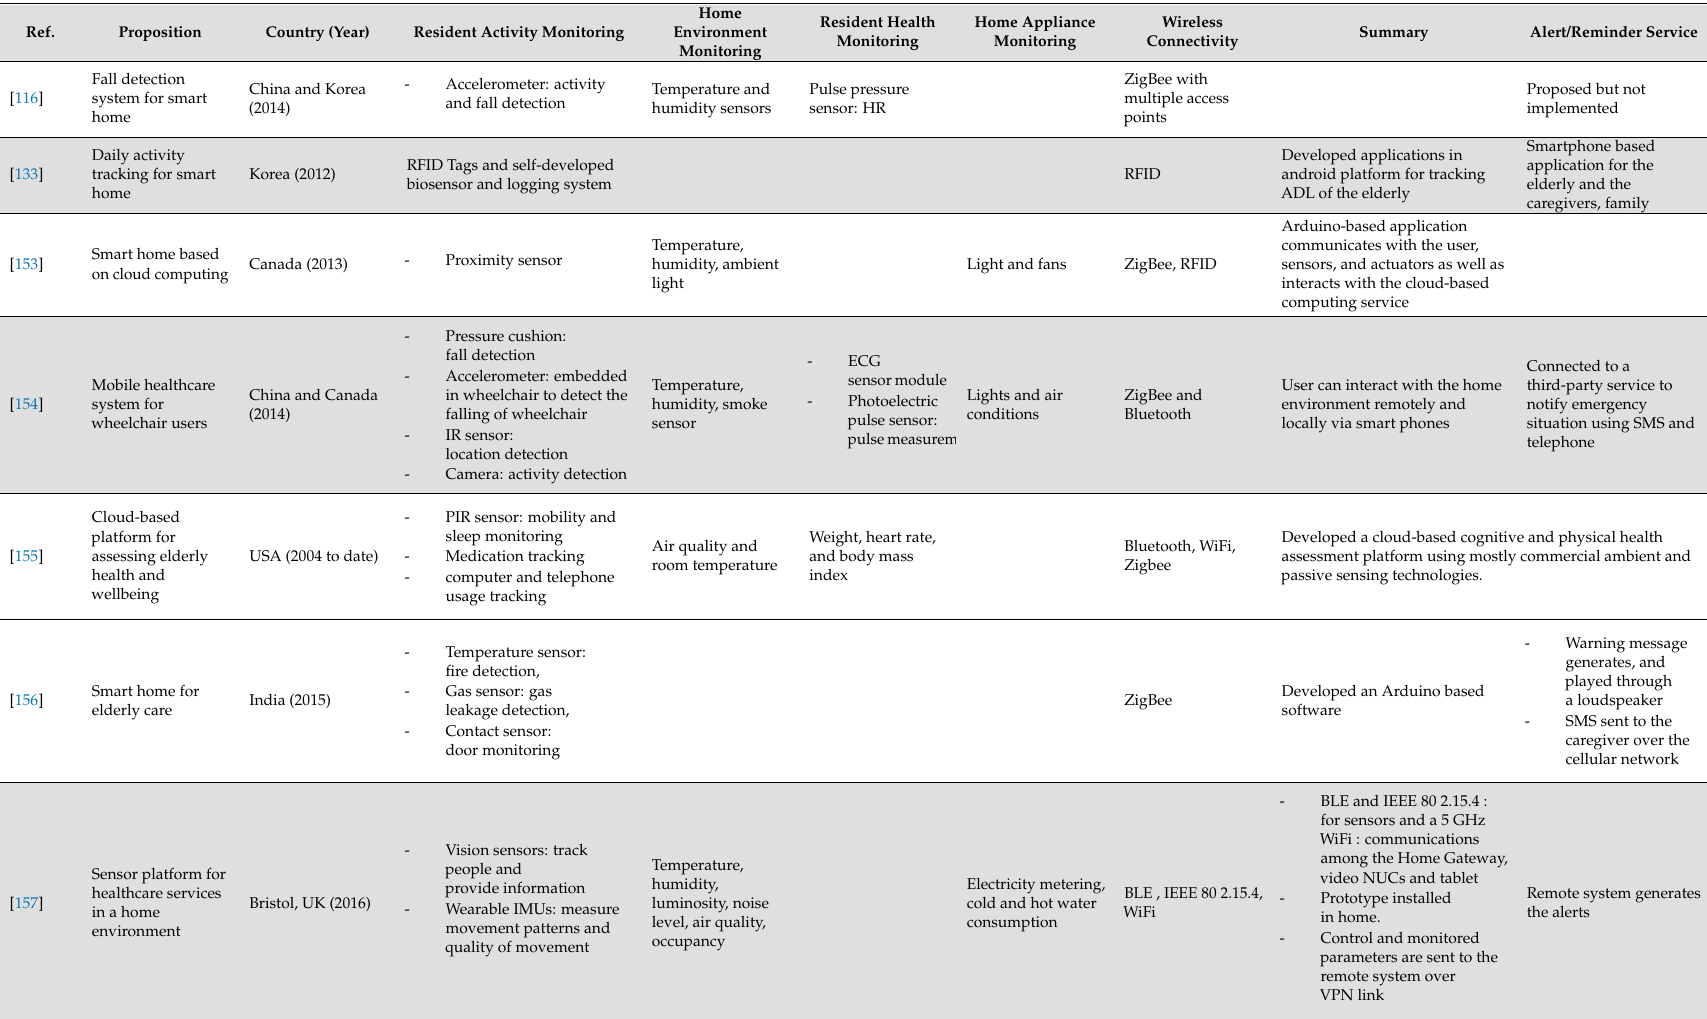
Table 3. Smart home